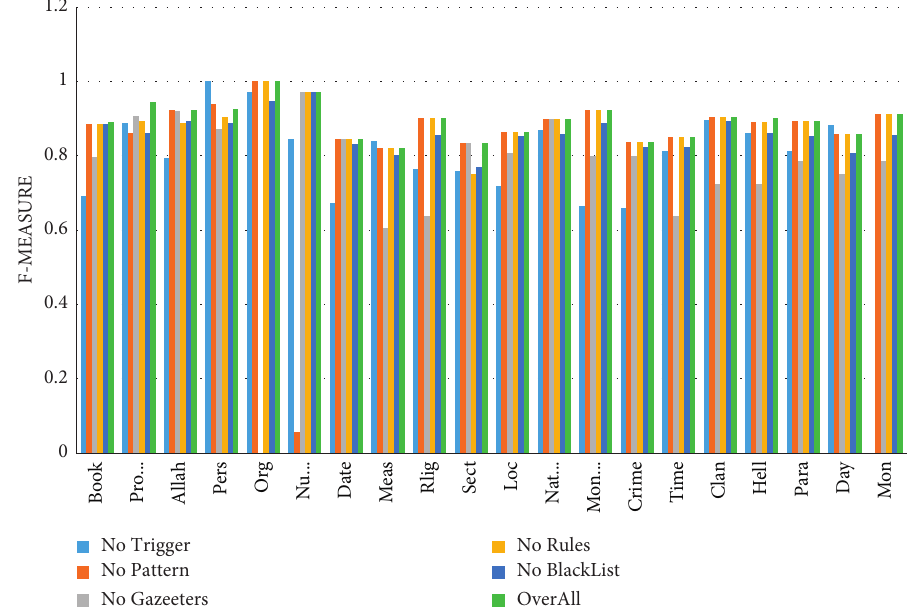
Figure 13: Comparison of features on CA NEs. Table 18: Evaluation of rule-based method.